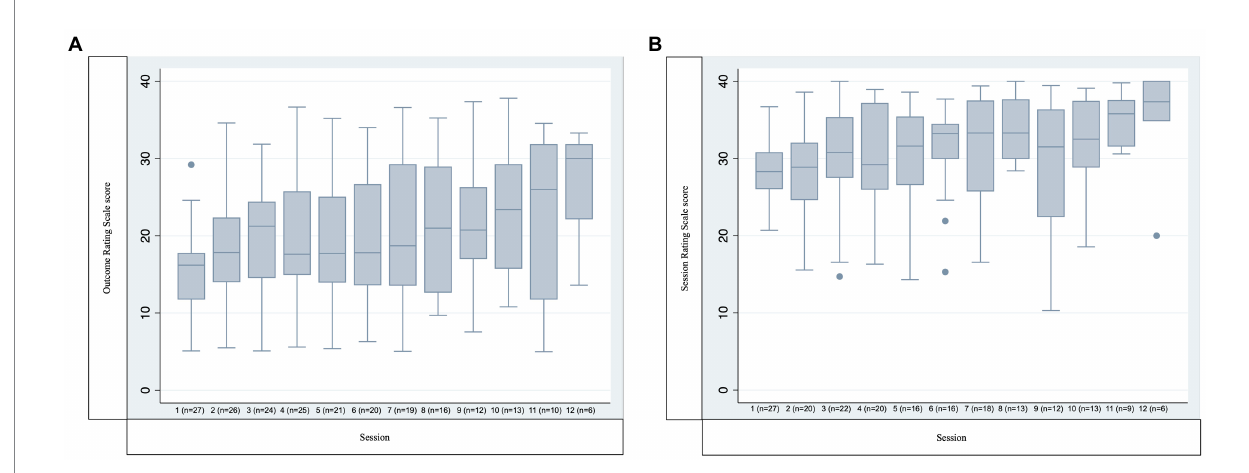
FIGURE 2 Outcome rating scale and session rating scale scores. (A) Outcome rating scale score. (B) Session rating scale score. Y -axis indicates the sum of all four items of each scale. X -axis indicates session number (and number of participants responding). Boxes represent median and interquartile range (IQR), whiskers represent the furthest point within 1.5 IQR of the nearer